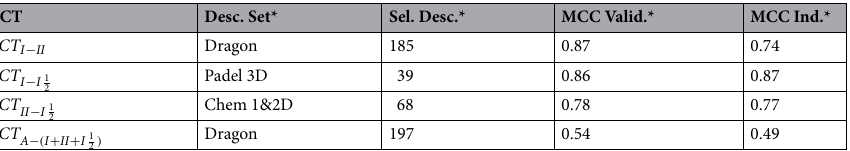
Table 1. The best predictive descriptor set for each classification task. Desc. Set*: Descriptor Set; *: No. of selected descriptors; MCC valid.*: MCC for validation set; MCC Ind.*: MCC for independent set.